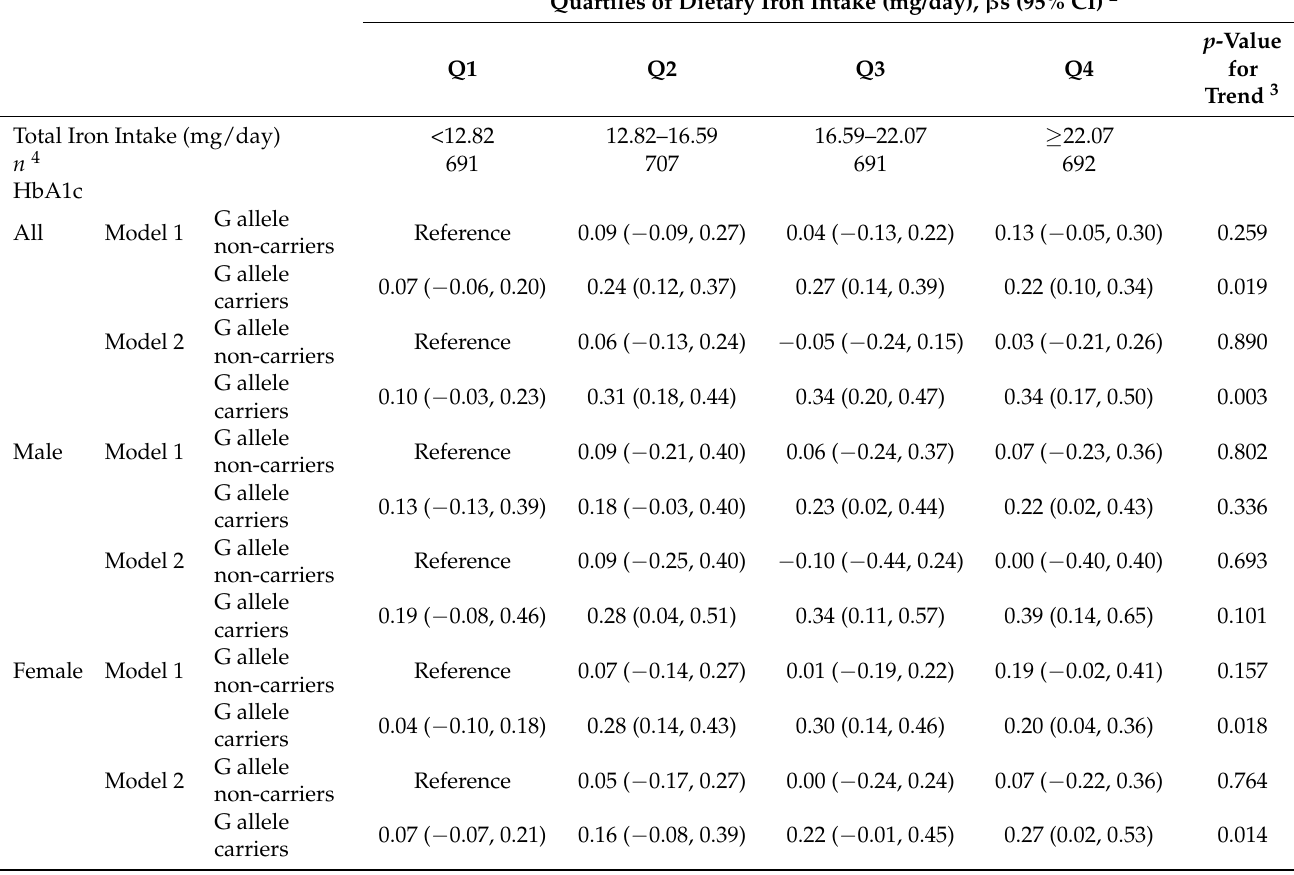
Table 5. β s (95% CI) for HbA1c according to the quartiles of dietary iron stratified by the rs10830963 risk allele in the MTNR1B gene among the participants 1